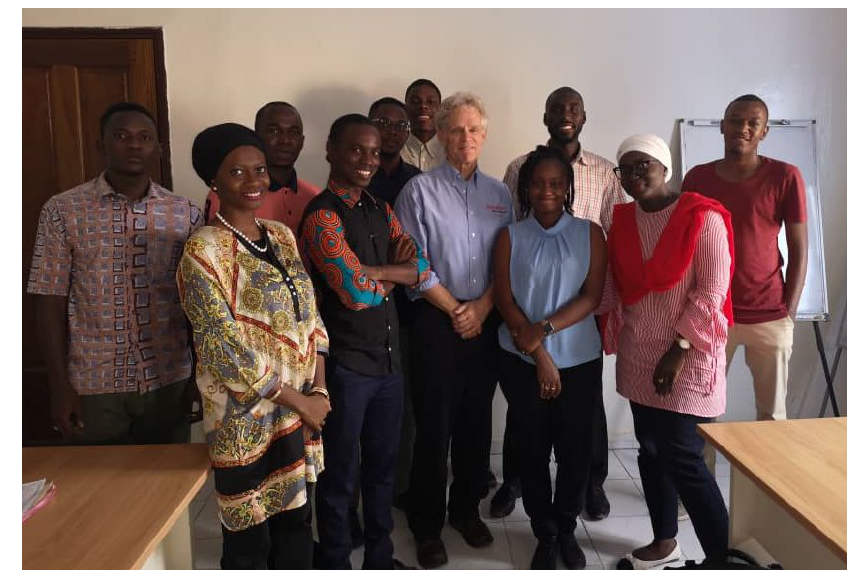
Figure 4: Teaching a short course at IFAGE (Institut interafricain de formation en assurance et en gestion des entreprises), 2019, in Dakar, Senegal. Pictured with Jed are students and fellow faculty, Rokhya Fati (second from left) and Rokhya Kandji (second from right).